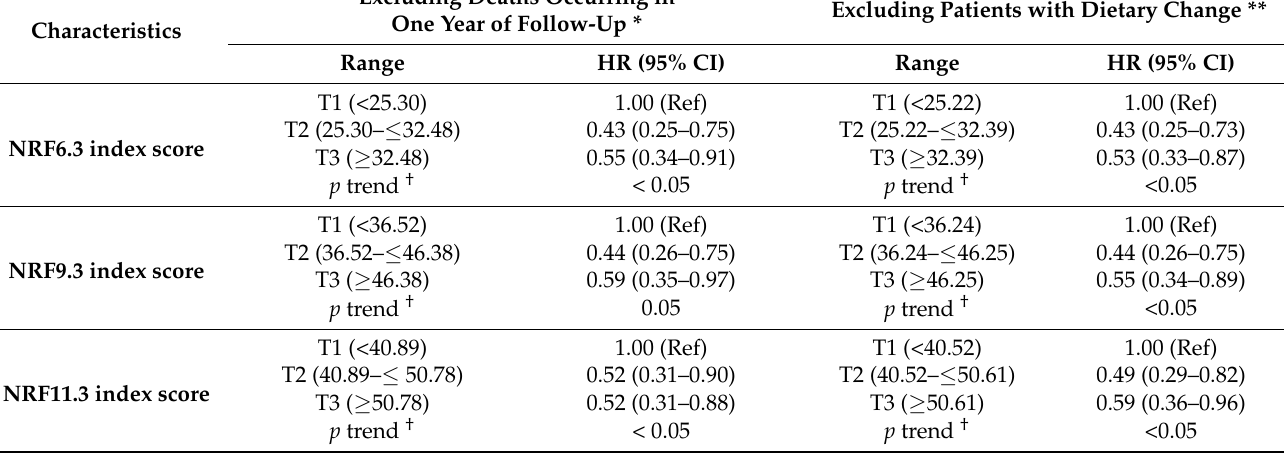
Table 4. Sensitivity analyses: the associations of tertiles of NRF index scores with overall survival of ovarian cancer